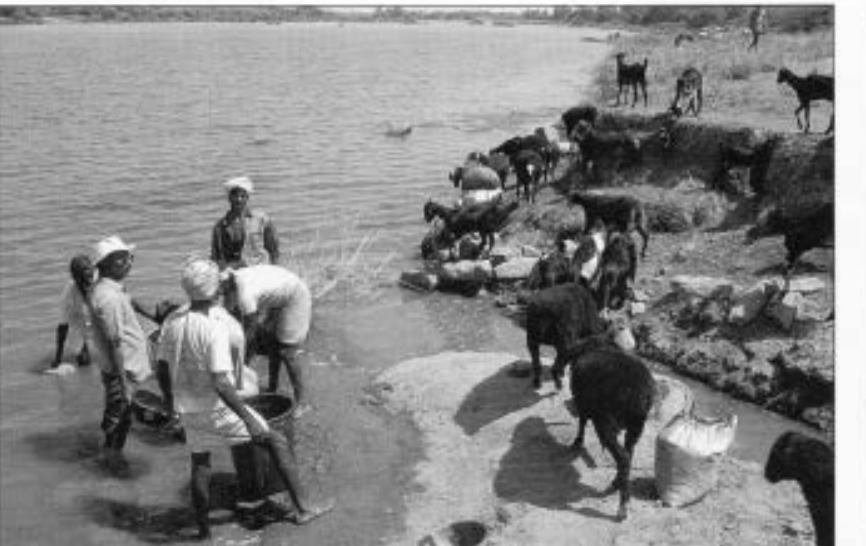
Figure 4 Flotation being carried out with buckets a11d 0.5 mm-mesh sieves at the site of Hallur on the banks of the Tungabhadra River. Professor Korrisettar of Karnatak Uni­ versity at left (white hat).